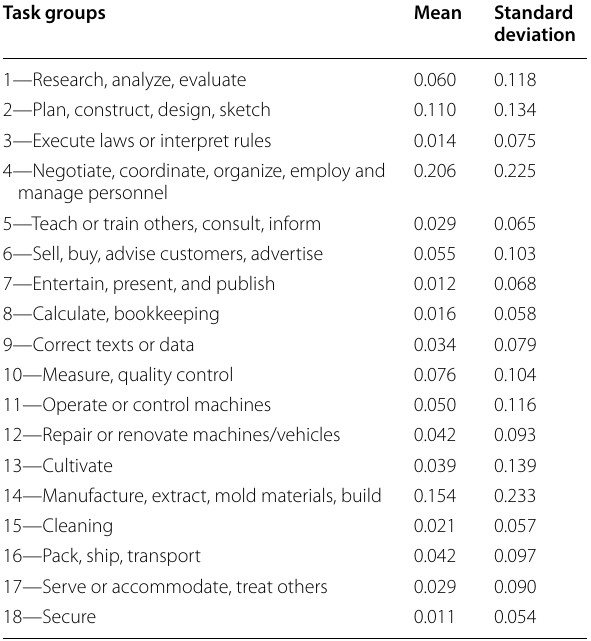
Table 5 Summary statistics of tasks across